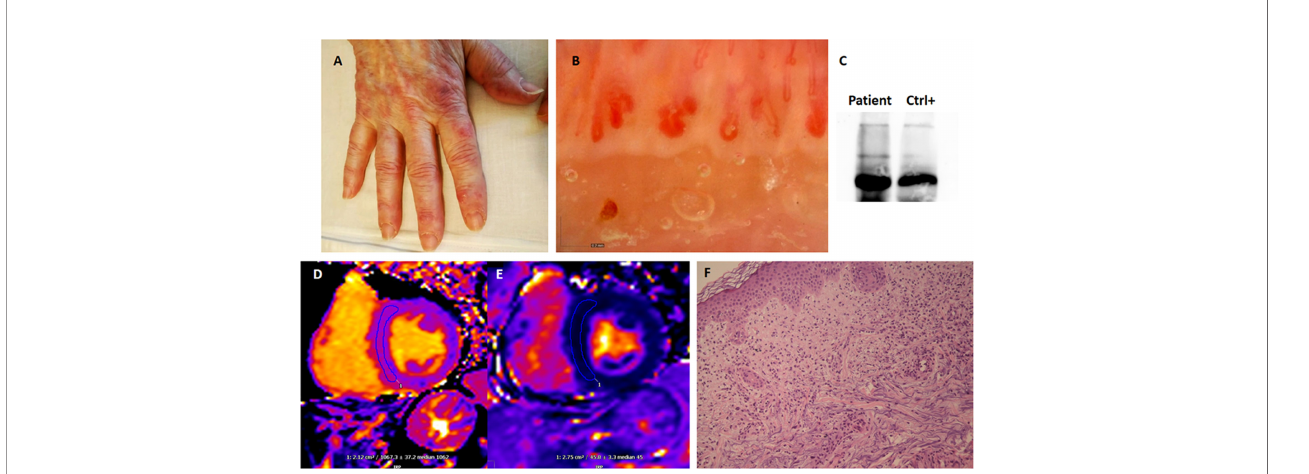
FIGURE 1 | Manifestations of COVID-19-associated anti-MDA5 dermatomyositis. (A) Cutaneous manifestations presented as violaceous, maculo-papular lesions on both dorsal and volar sides. (B) Nailfold video-capillaroscopy illustrated reduced capillary density, neo-angiogenesis, and tortuous, ectasic and giant capillaries. (C) Anti-MDA5 antibodies detected by immunoprecipitation. (D, E) T1-weighted cardiac magnetic resonance images presenting increased signal intensity [native T1 = 1067 ± 37msec (NV < 1015)], which, in association with ECV = 30 ± 4% (NV < 29) and normal T2 intensity [native T2 = 46 ± 3 msec (NV < 50 msec)], indicates interstitial myocardial fi brosis and is consistent with previous myocarditis. (F) Skin punch biopsy of a Gottron-like lesion on the left hand showing patchy mixed super fi cial in fl ammatory in fi ltrated with leukocytoclastic vasculitis features (Hematoxylin and eosin, 20x magni fi